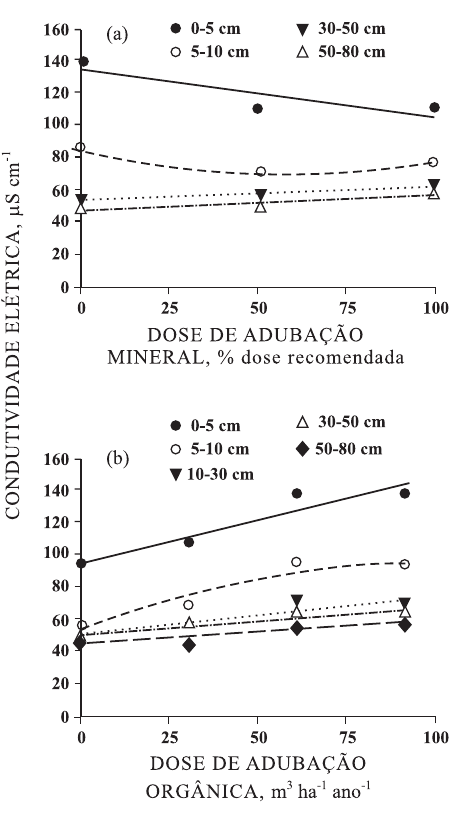
Figura 4. Condutividade elétrica em sistema plantio direto submetido à adubação com diferentes doses de esterco líquido de gado leiteiro (a) e adubação (b), durante seis